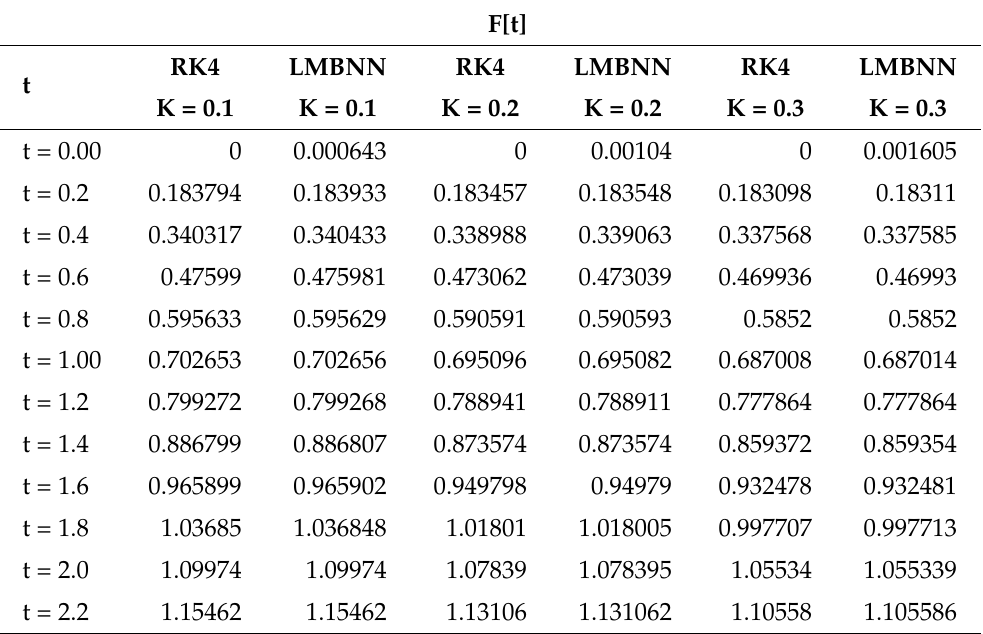
Table 3. Different values of F were obtained by RK4 and LMBNN methods when rotation parameter K varies (from